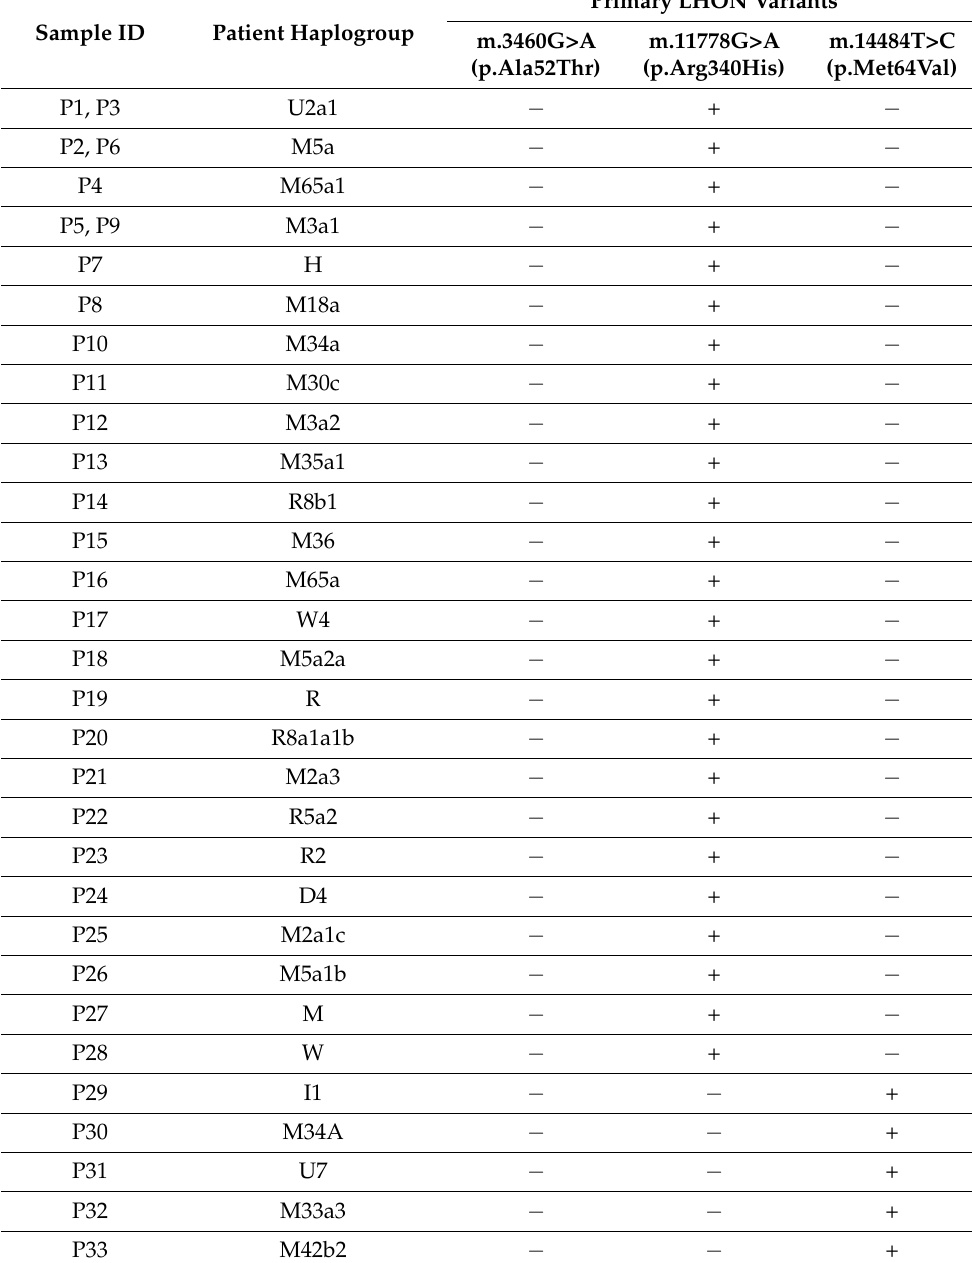
Table 2. Patients harbouring primary LHON variants and their mtDNA